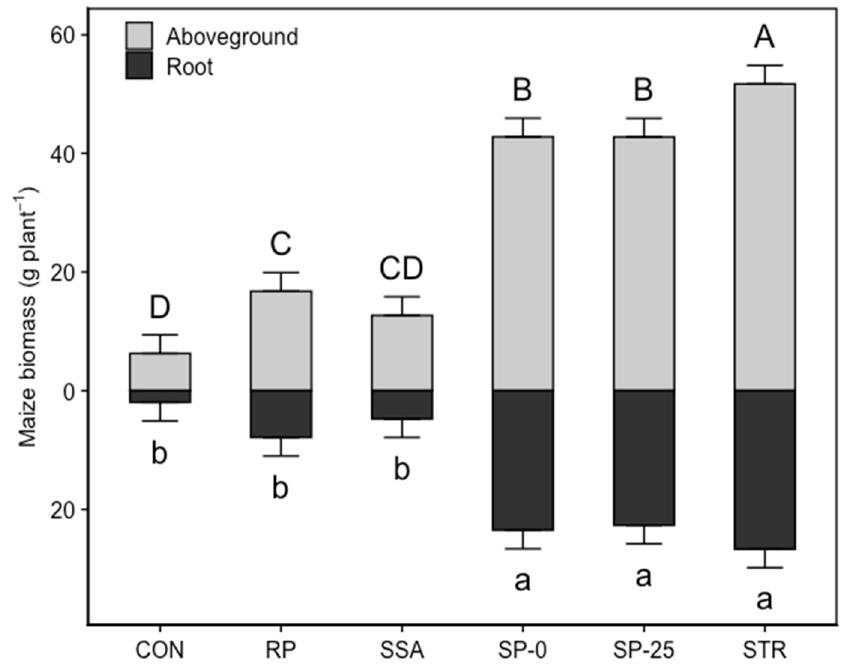
Figure 3. Mean values of maize biomass (g plant − 1 ) after 10 weeks of growth. The same letters indicate no significant differences between the treatment ( n = 4, Tukey ´ s HSD test ( α = 0.05)). Error bars indicate standard error of the mean. For fertilizer abbreviations, see Table 1. Table 5. Mean values of maize aboveground biomass P concentration (mg kg − 1 ) and P content (mg P plant − 1 ) after 10 weeks of growth. The same letters indicate no significant differences between the treatments ( n = 4, Tukey´s HSD test ( α = 0.05)). For fertilizer abbreviations, see Table 1.